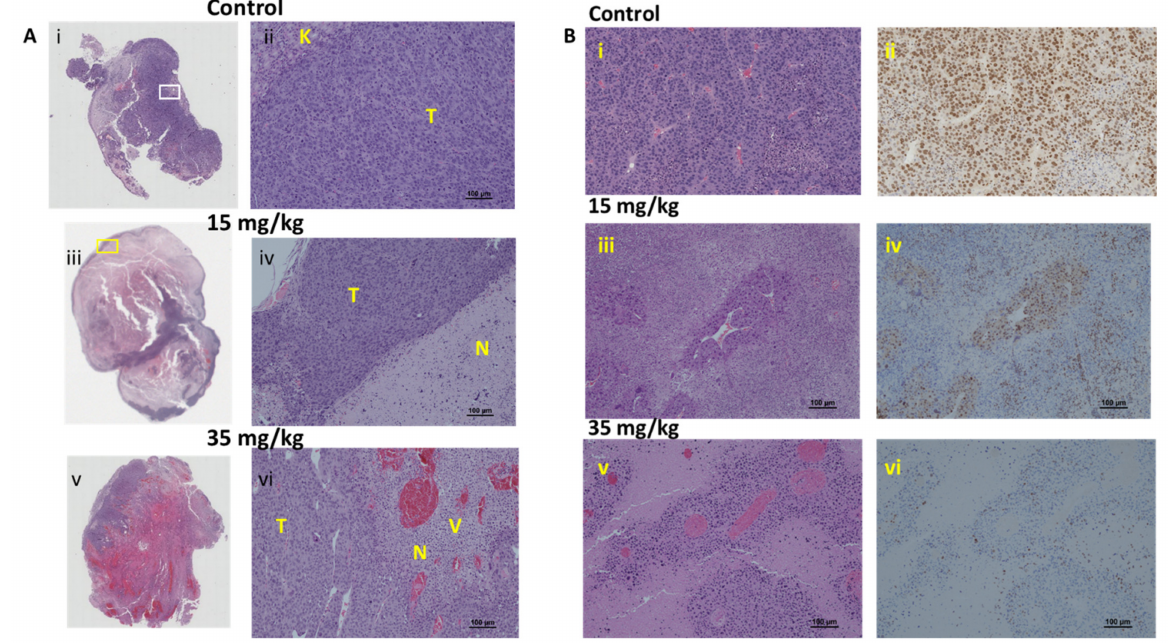
Figure 8. Histology of RENCA-luc tumors. ( A ) H&E stained whole mount sections and correspond- ing magnified regions obtained from RENCA-luc tumors 24 h after administering saline or